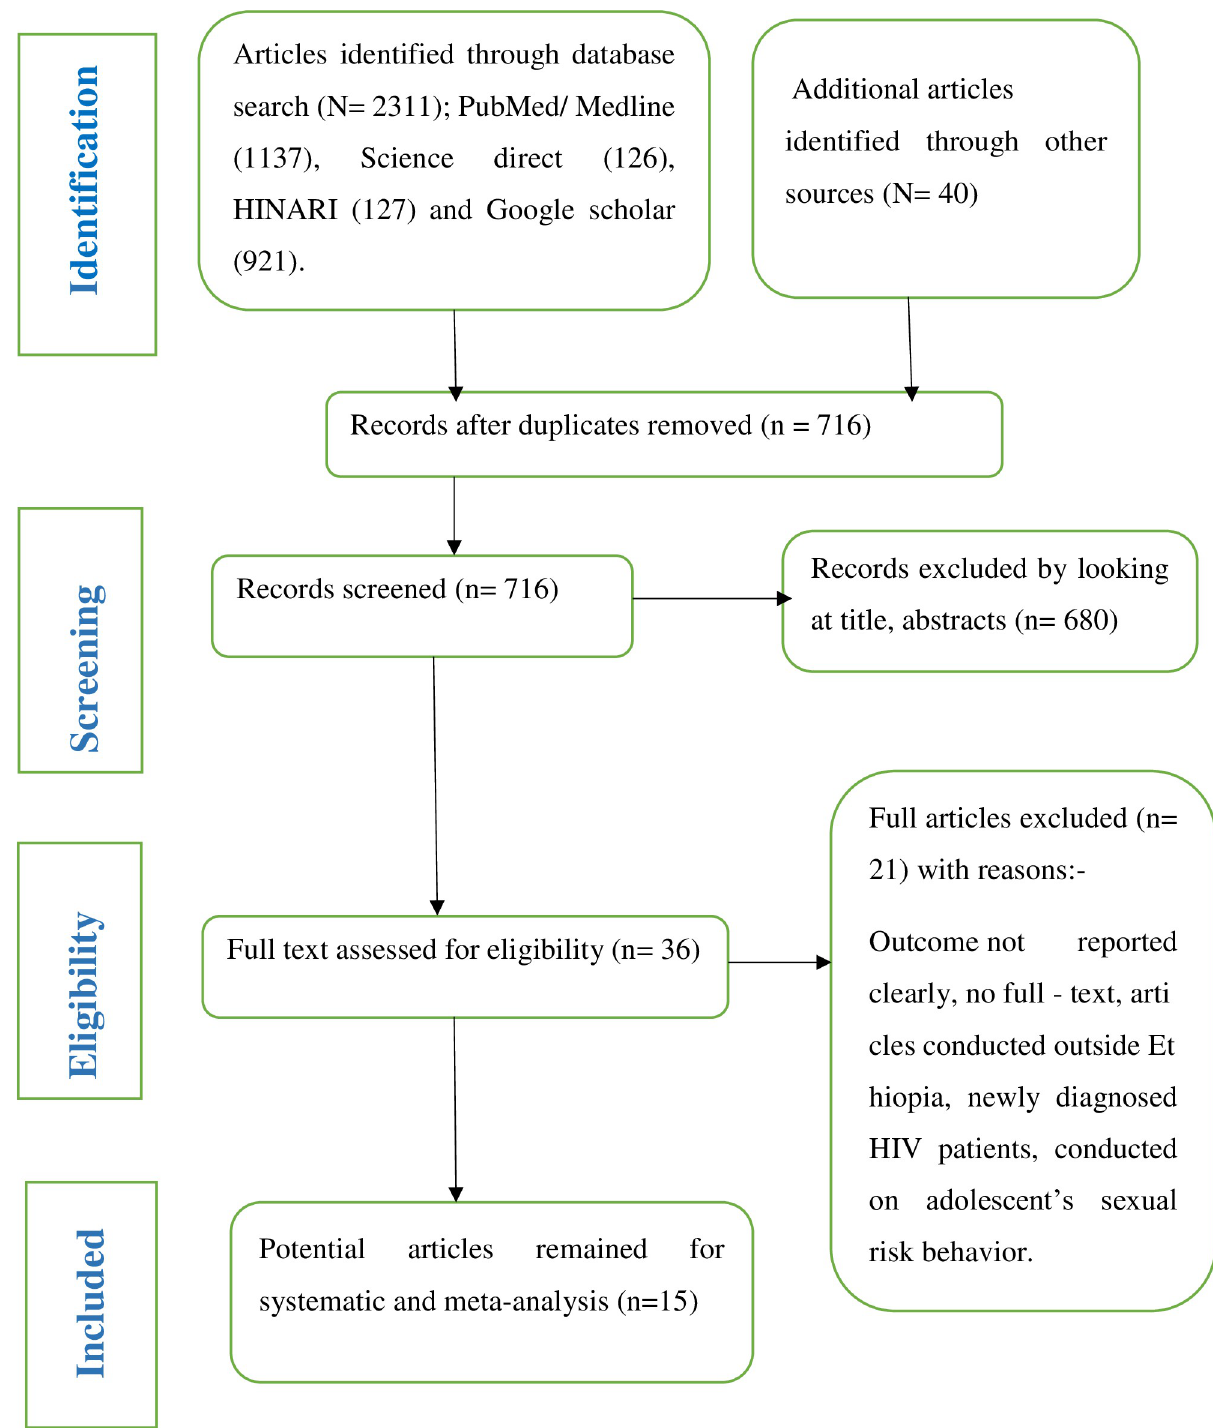
Fig 1. PRISMA flow diagram which shows the selection of articles for systematic review and meta-analysis.